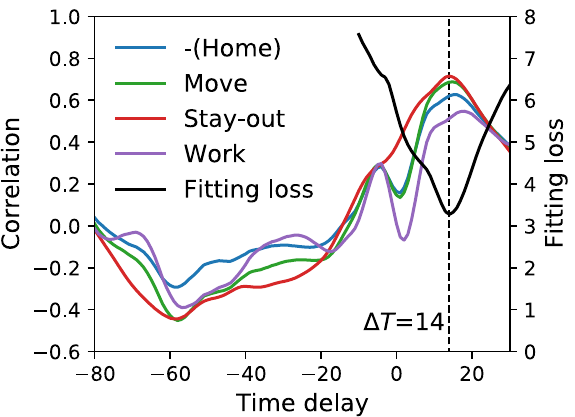
Figure 2. Correlation between the effective reproduction number and the population moments time series delayed by (cid:31) T , and fitting loss to the effective reproduction number by the population moments as a function of the delay (cid:31) T in the period 200 ≤ t < 500 . The fitting loss is calculated as the residual of the square sum in the log space. For the correlation, the peak and trough are observed at around (cid:31) T = 14 and (cid:31) T = − 60 , respectively. For the fitting loss, it is minimized at (cid:31) T = 14 .